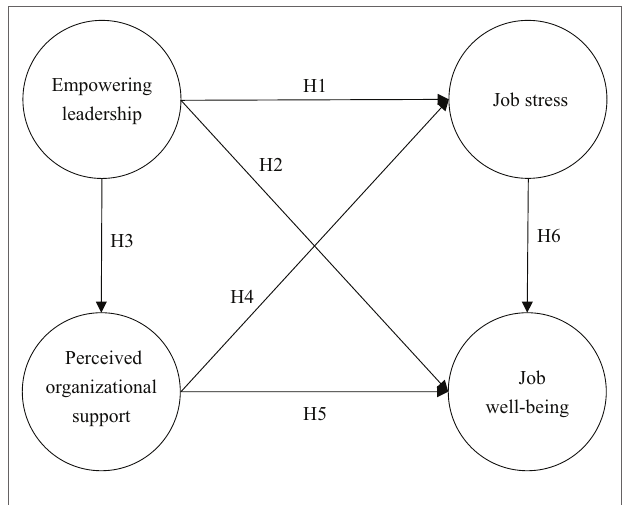
FIGURE 1 | Research